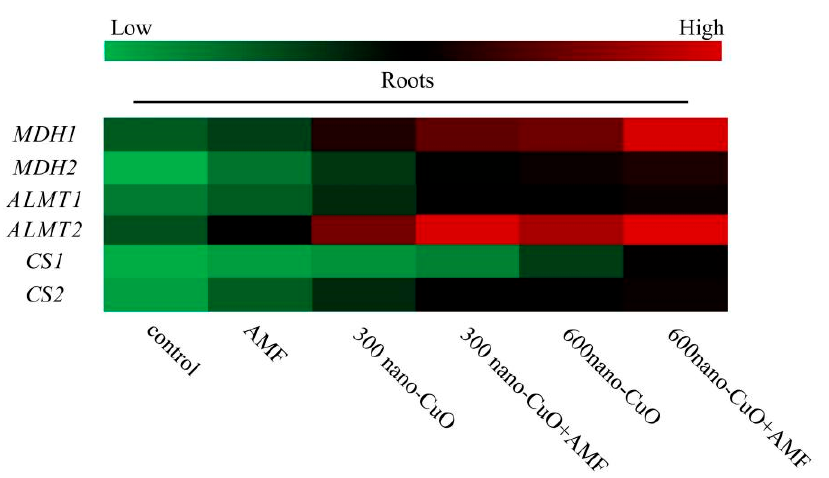
Figure 8. The effect of AMF on the expression of malic acid and citric acid metabolism-related genes under nano-CuO stress in C. indica roots. MDH: malate dehydrogenase; ALMT: aluminum-activated malate transporter; CS: citrate synthase. Different colors represent gene expression levels from lowest (green) to highest (red) in the entire database. The RT-PCR assays were performed in three independent biological replicates and three technical replicates.